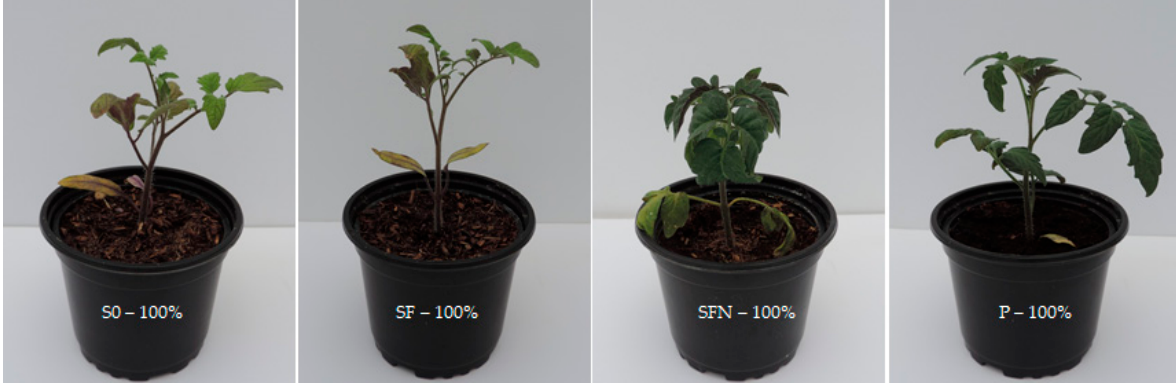
Figure 2. Selected tomato transplants (S0—salix compost; SF—salix compost with fungi decomposer; SFN—salix compost with fungi decomposer and mineral nitrogen; P—peat).